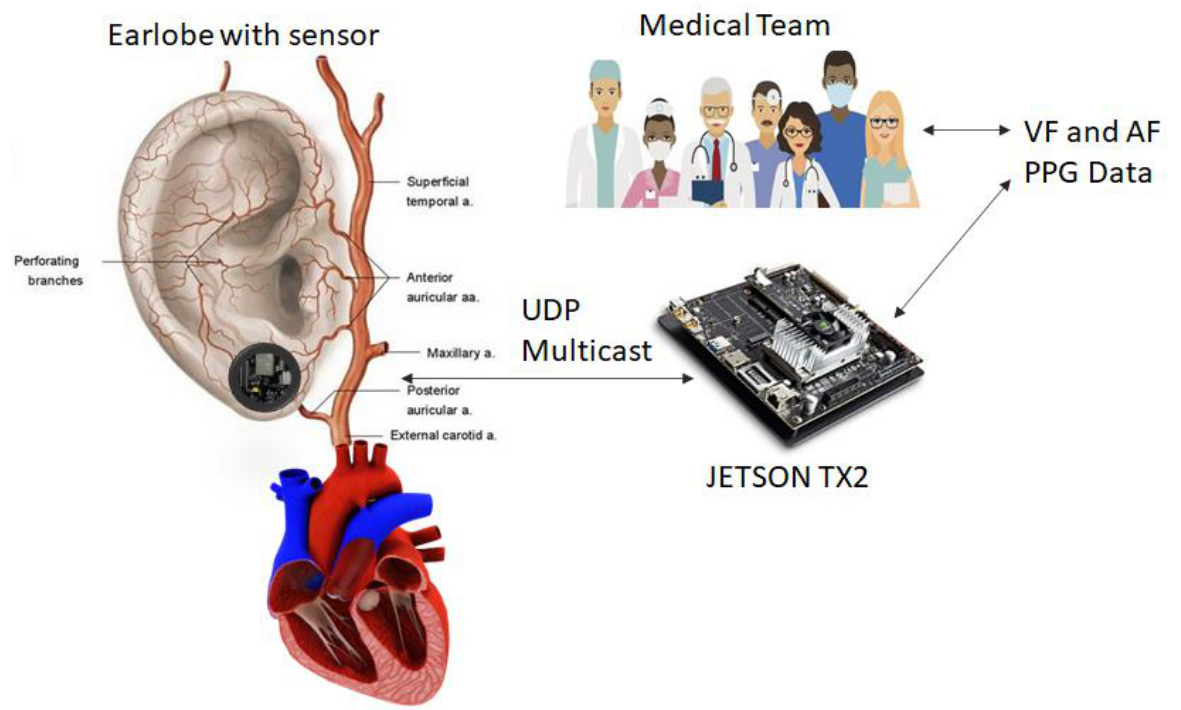
Figure 6. System Design using Circular Earlobe sensor and Jetson Tx2.